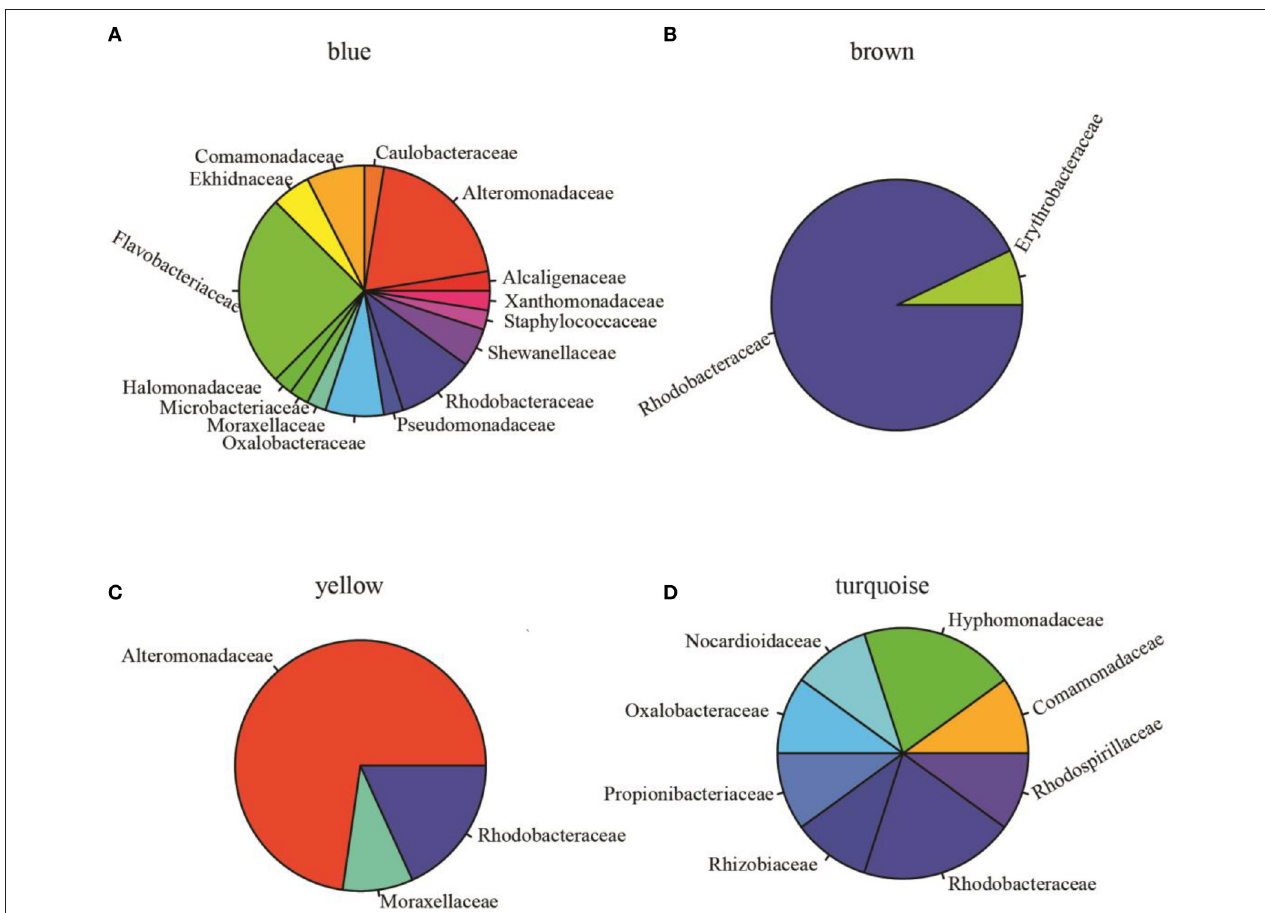
FIGURE 3 | Relative abundance of OTUs at the family level (indicated by different colors) in identified modules. (A) Blue module (total OTUs 40 annotated at family level, 127 OTUs unassigned at family level are not shown) was dominated by Flavobacteriaceae (25%, n = 10) and Alteromonadaceae (20%, n = 8). (B) Brown module (14 OTUs annotated, 63 unassigned) was dominated by Rhodobacteraceae (92%, n = 13). (C) Yellow module (total OTUs 11 annotated at family level) is comprised of Alteromonadaceae (72%, n = 8), Rhodobacteraceae (9.1%, n = 1), and Moraxellaceae (9.1%, n = 1). (D) Turquoise module (10 OTUs assigned to 8 families, 876 unassigned OTUs) is comprised of 8 families. These data showed that Rhodobacteraceae was significantly enriched in the brown module (one-sided Fisher’s exact test, P < 0.0001) and Alteromonadaceae was significantly enriched in the yellow module (one-sided Fisher’s exact test, P < 0.05).